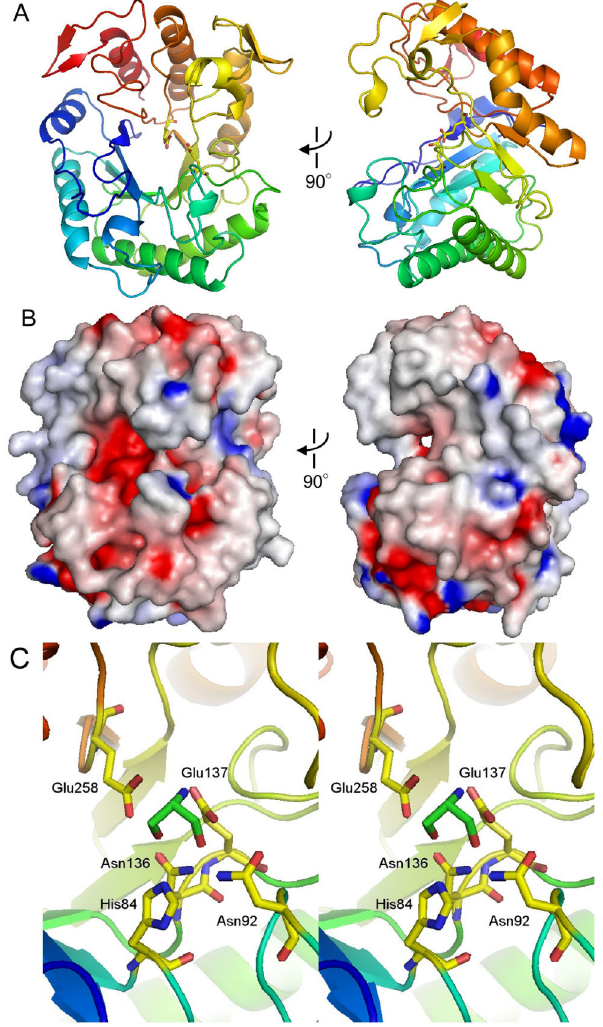
Figure 1. Crystal structure of C . polysaccharolyticus Man5B . A, The structure is shown as a ribbon representation with a color spectrum from blue (N-terminus) to red (C-terminus). B, Orthogonal views of the molecular surfaces of CpMan5B colored according to the electrostatic potential. C, Close-up view of the Tris molecule bound to the active site of CpMan5B. The Tris molecule and the contacting residues are highlighted by a stick